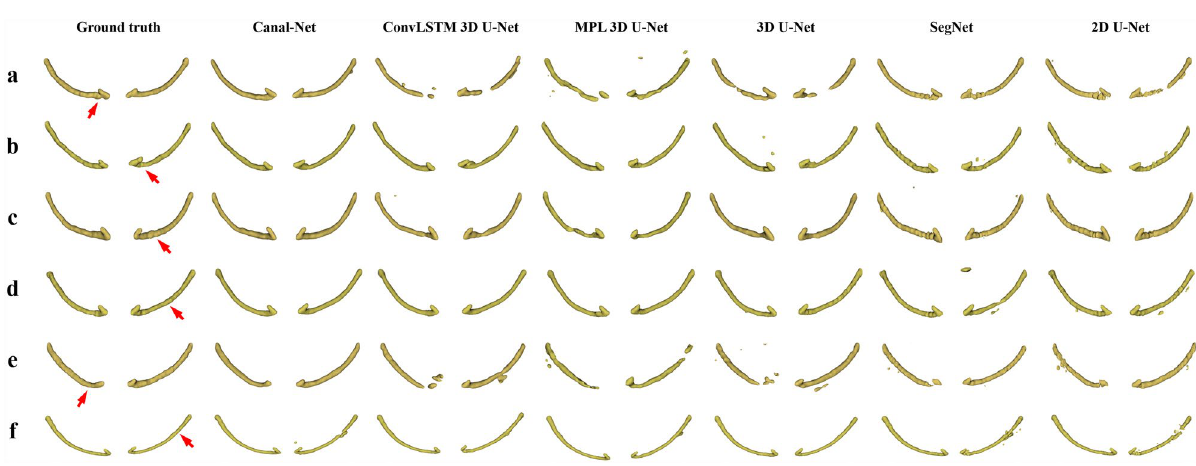
Figure 4. The 3D reconstructed whole canal from the ground truth and segmentation results by Canal-Net (ours), ConvLSTM 3D U-Net (ours), MPL 3D U-Net (ours), 3D U-Net, SegNet, and 2D U-Net from the top to bottom ( a–f ) from the same canals shown in Fig. 3a–f. The red arrows indicate the position of the corresponding image slice in Fig.